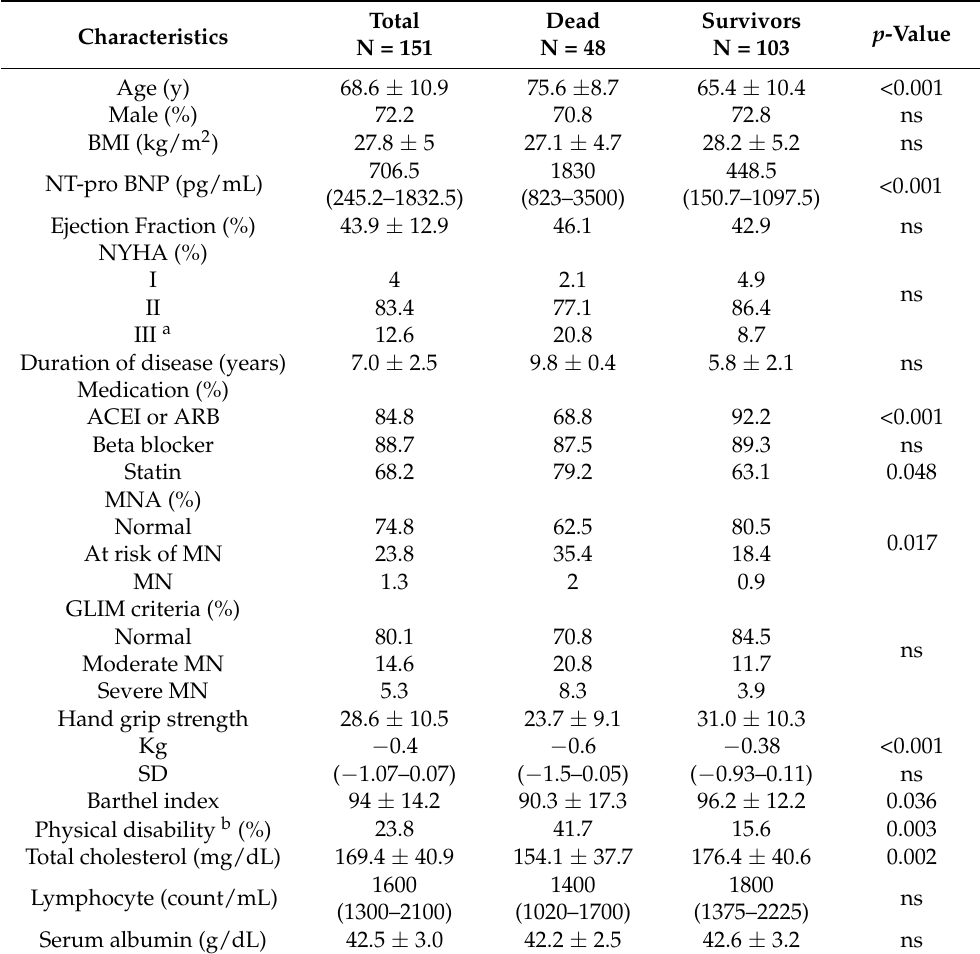
Table 1. Demographic and clinical characteristics of patients with HF that died or survived during the five-year follow-up